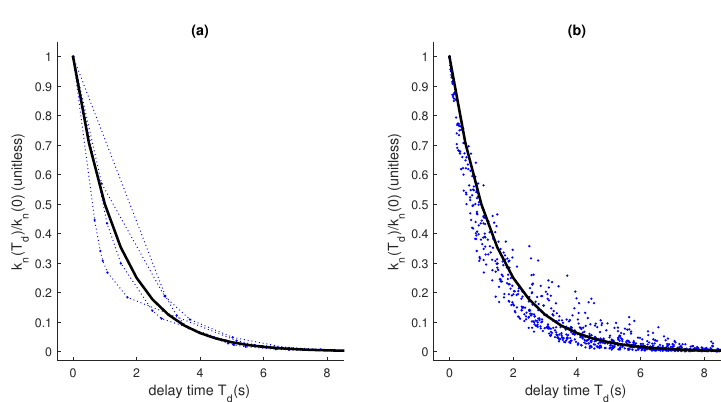
Figure 2. Typical- λ approximation. Dashed blue lines/dots: many runs. Thick black line: ( 1 − k n ( ∆ T P ) h ) T d / ∆ T P , where k n ( T d ) is given by (6), λ = 1, σ 2 displayed without connecting lines.